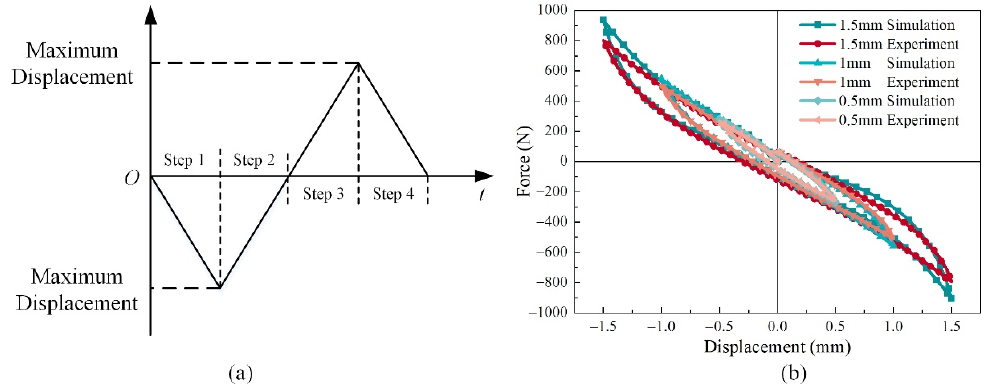
Figure 12. Step and results of static experiments and FEM simulations: ( a ) loading steps schematic, ( b ) results under different maximum displacements.